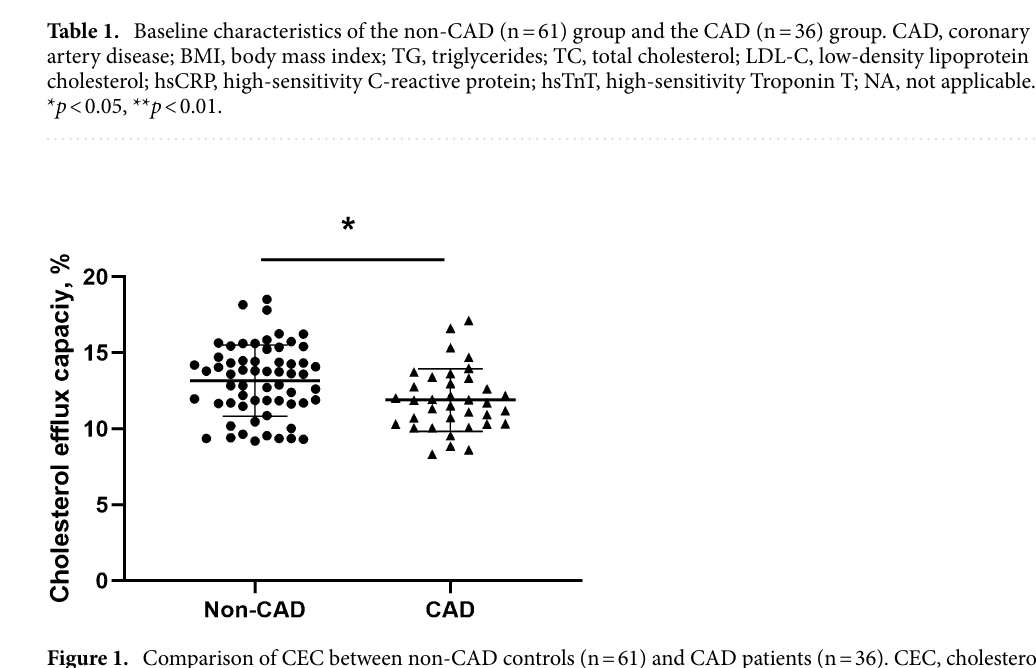
Figure 1. Comparison of CEC between non-CAD controls (n = 61) and CAD patients (n = 36). CEC, cholesterol efflux capacity; CAD, coronary artery disease; * p < 0.05. Data analysis was performed using SPSS version 25.0 (IBM, USA, https:// www. ibm. com/ analy tics/ spss- stati stics- softw are) and the figure was made by GraphPad Prism version 8.0 (GraphPad Prism Inc, USA, https:// www. graph pad. com/ scien tific- softw are/